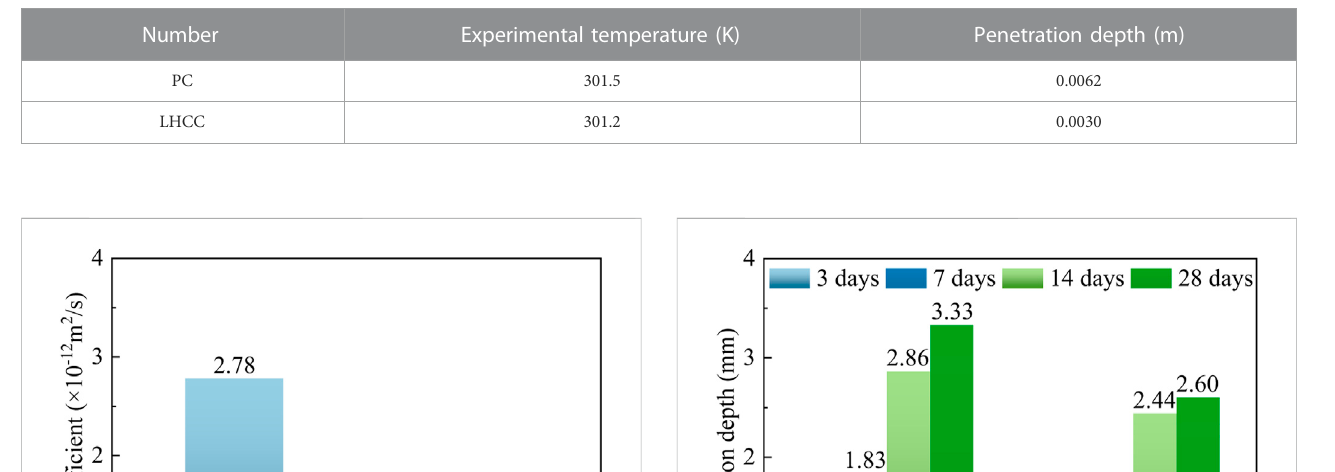
TABLE 4 Chloride ion penetration experiment results.